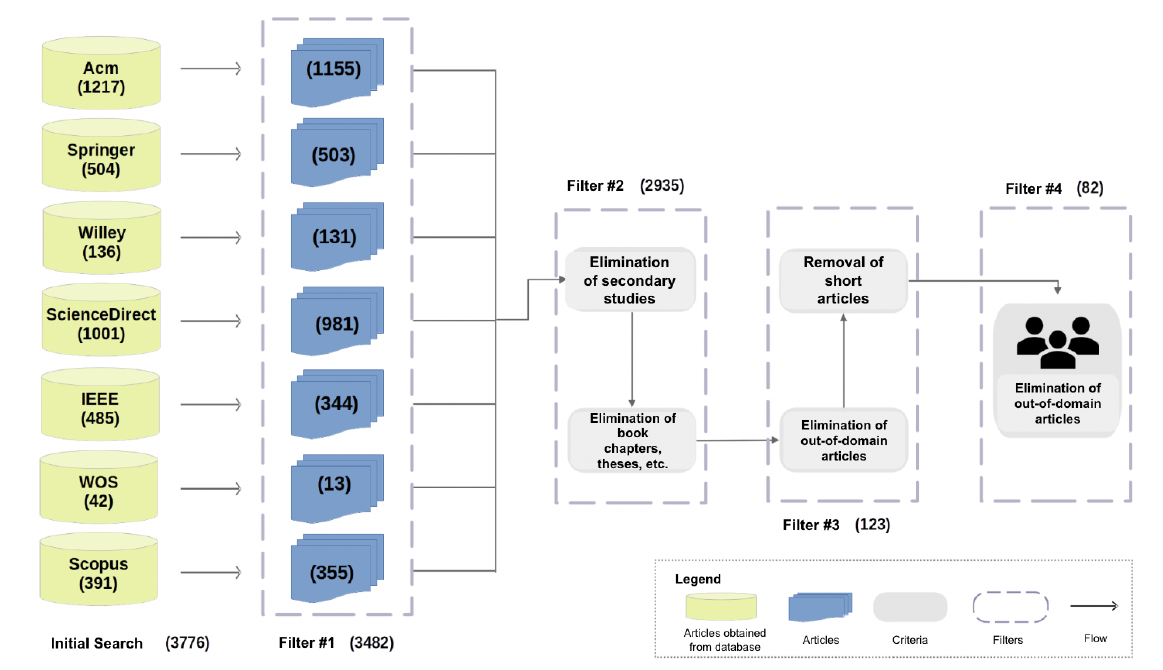
Figure 3. Article filtering